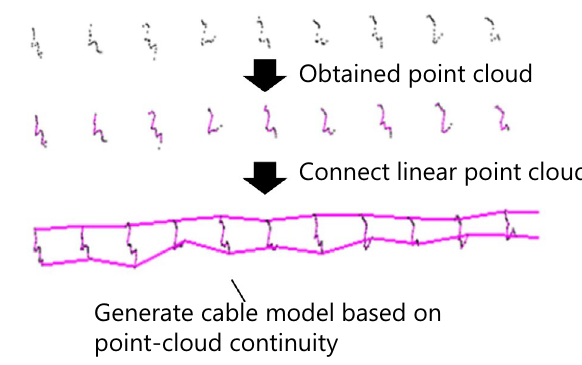
Fig. 2 3D modeling using rule-based method. Generate model by connecting the same direction vectors from PCA results of clus- tered point cloud